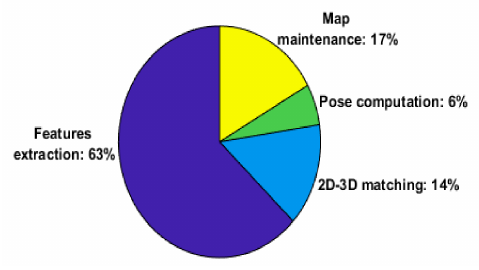
Figure 4. Relative runtime speed of the main stages of the visual odometry